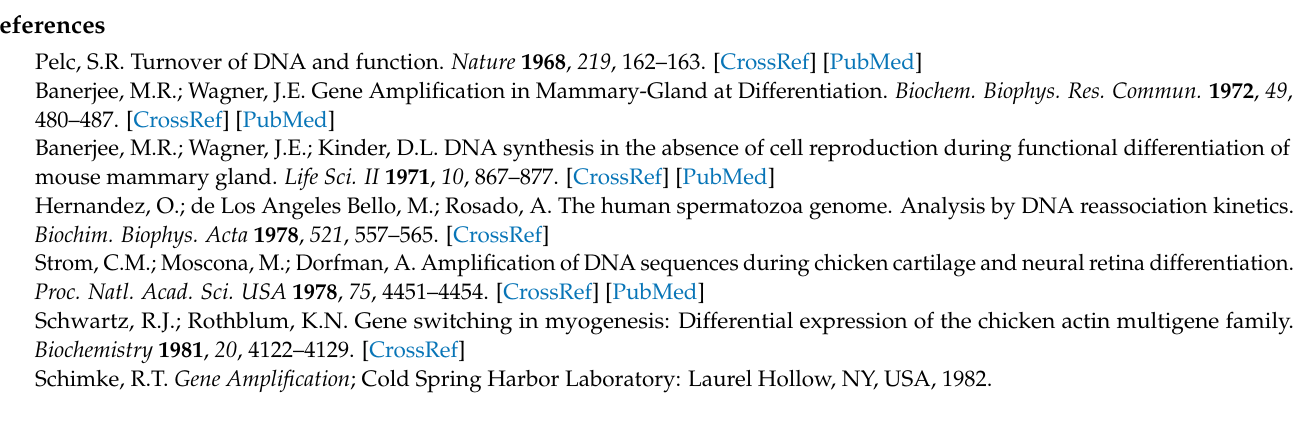
Figure 4. Hypothesized process on how stem and progenitor cells with gene mutations develop into tumor cells. The processes of re-replication and amplification leading to tumor development is exemplarily shown for astrocytes. As in the regular differentiation of stem and progenitor cells the re-replication causes gene amplification (see Figure 3). However, in the subsequent processes the gene mutations (indicated by red asterisks) of the stem and progenitor cells causing disintegration of the onionskin-like structure into small circles and open-ended DNA, which in turn lead to further gene amplification by breakage–fusion–bridge cycles as indicated by the schema on the left-hand